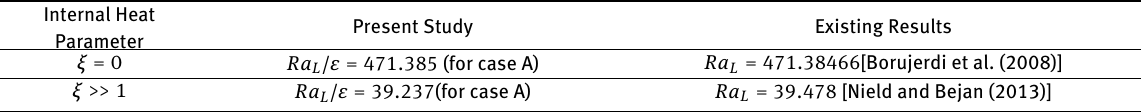
Table 1: Comparison of the present study with the existing results.